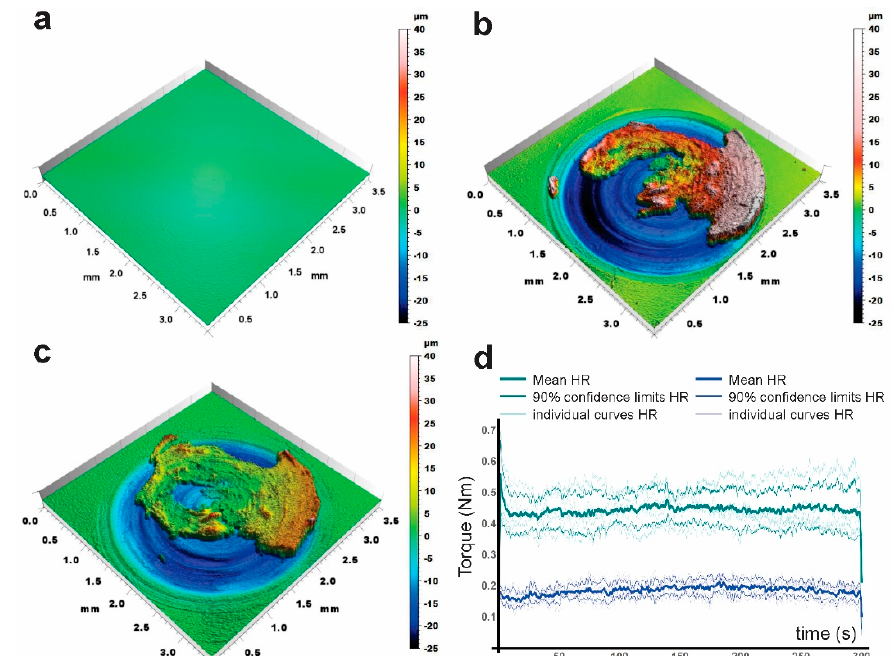
Figure 2. Optical profilometry of the surfaces before and after the test. ( a ): Before testing, ( b ): AC, ( c ): HR) and ( d ) torque measurements during the test, showing the point-by-point averages of 5 tests (5 samples, 30,000 points per curve) and the corresponding point-by point confidence intervals. The 5 individual curves for AC and HR are presented in faint colours as a background.